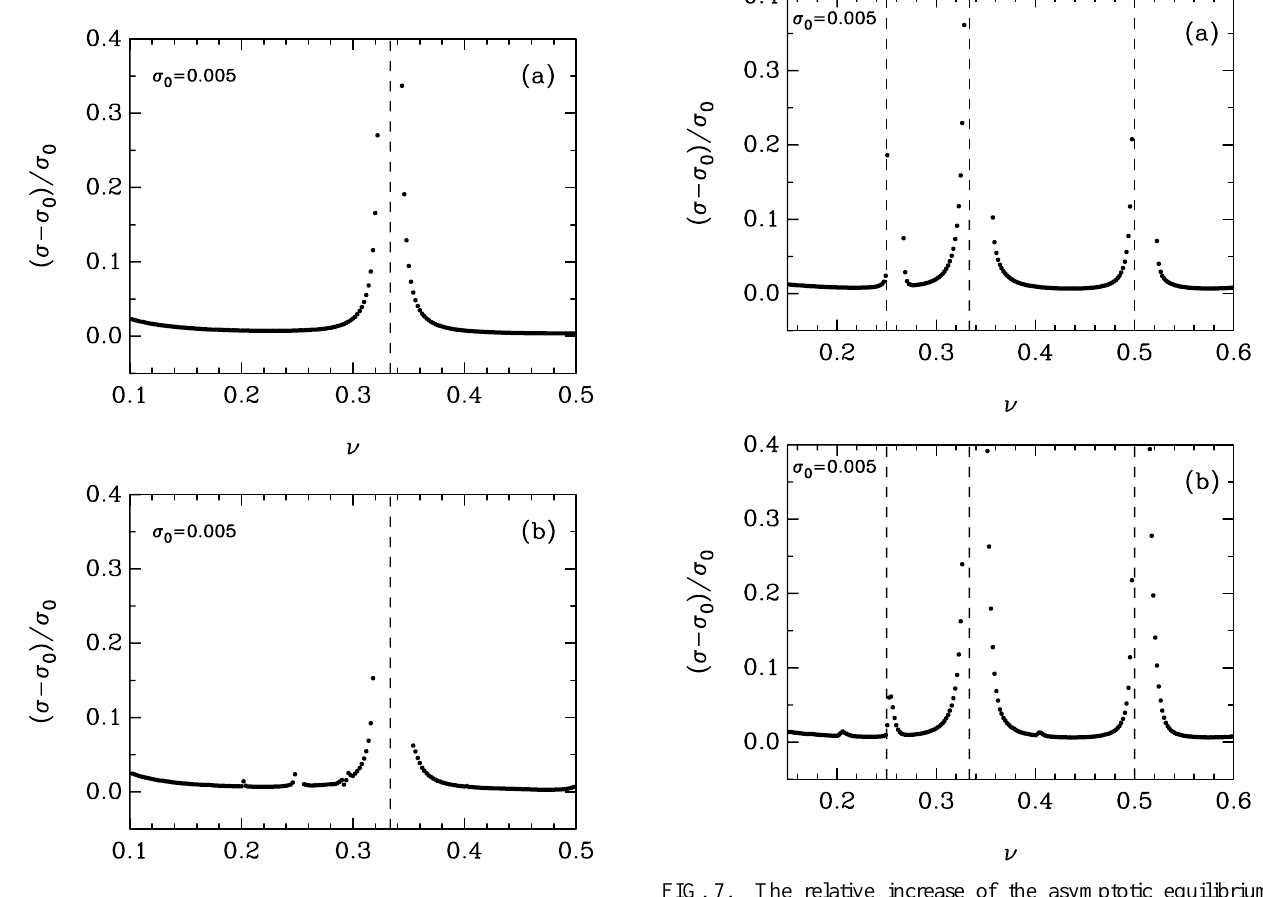
, (cid:49) , and (cid:49) . Note (cid:50) (cid:51) (cid:52)